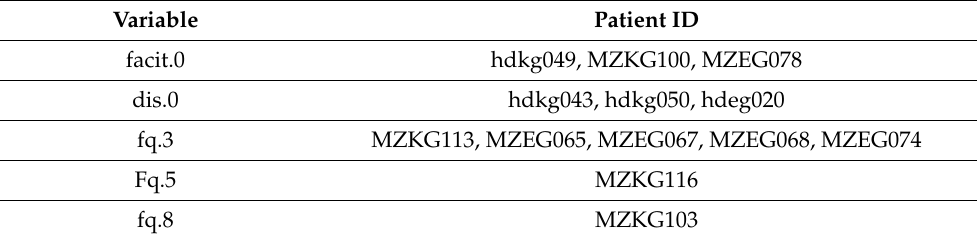
Table 2. Variables with a missing value to be filled by CFA.